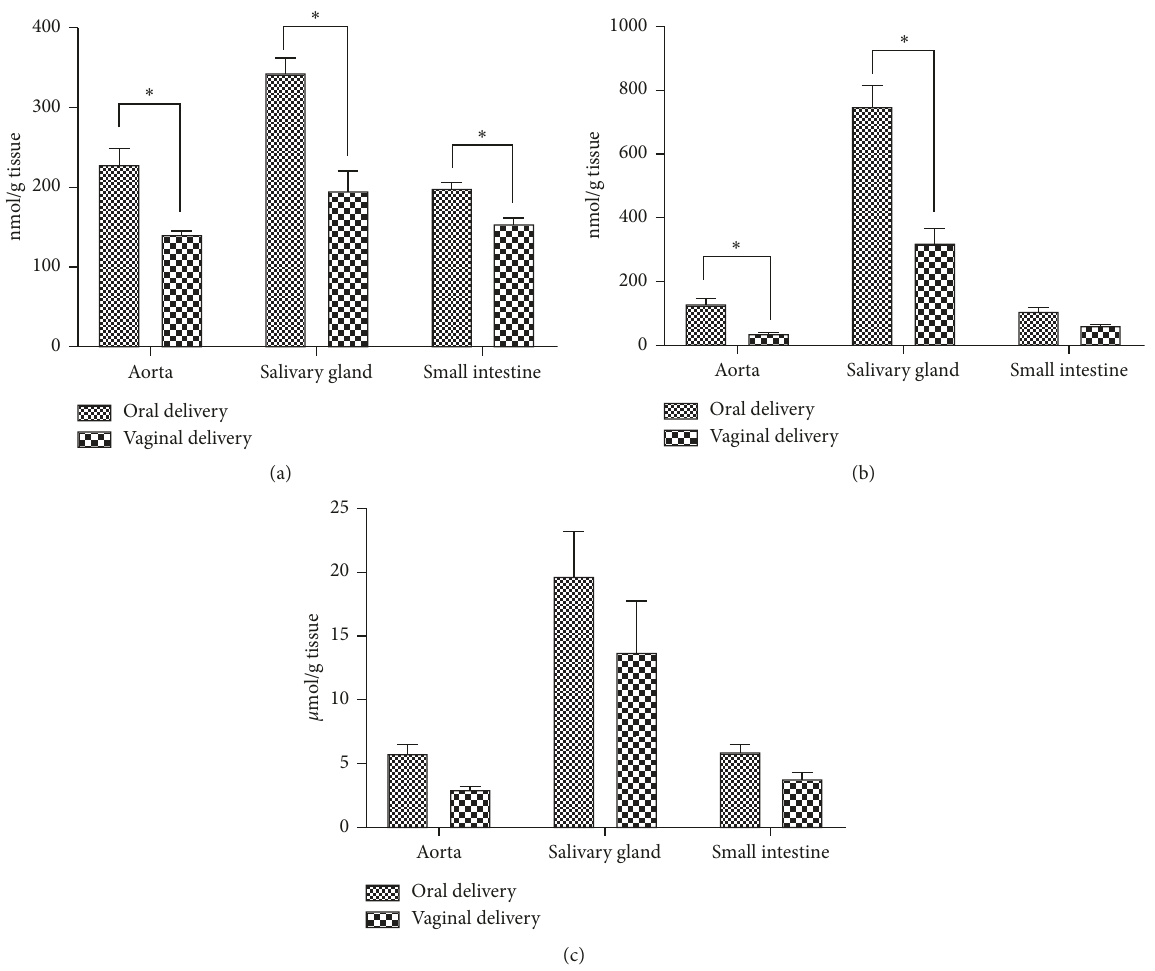
Figure 1: Effects of the oral and vaginal delivery of oxybutynin on NOx (a), TBARs (b), and GSH (c) levels in various tissues. p compared to the oral and vaginal delivery